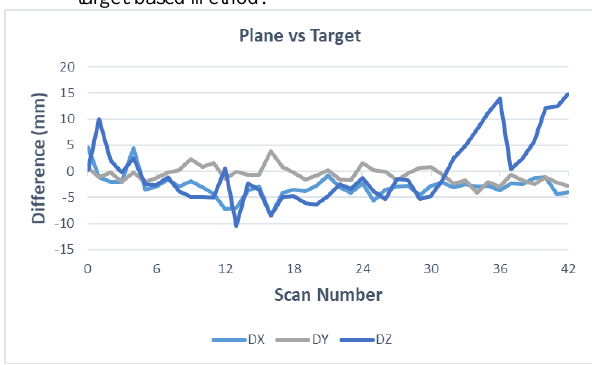
Figure 18. Case Study 2: 3D view of the registered scan with the target-based method.